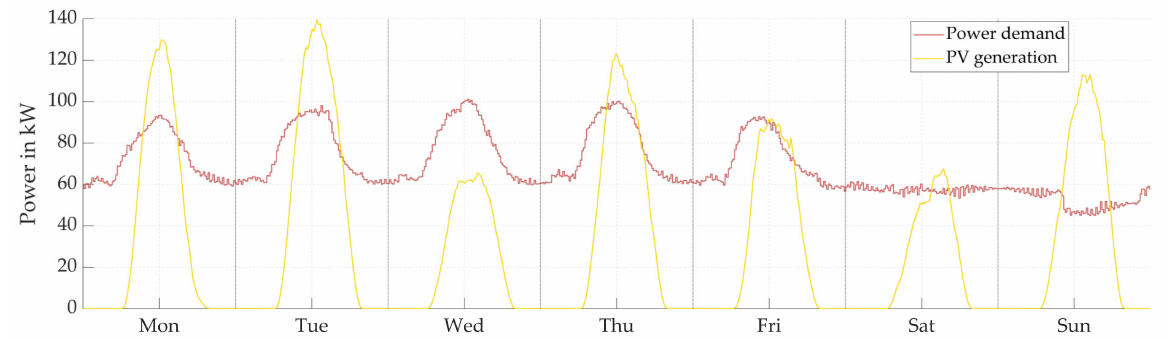
Figure 12. Energy demand of the commercial load for one week’s operation and PV